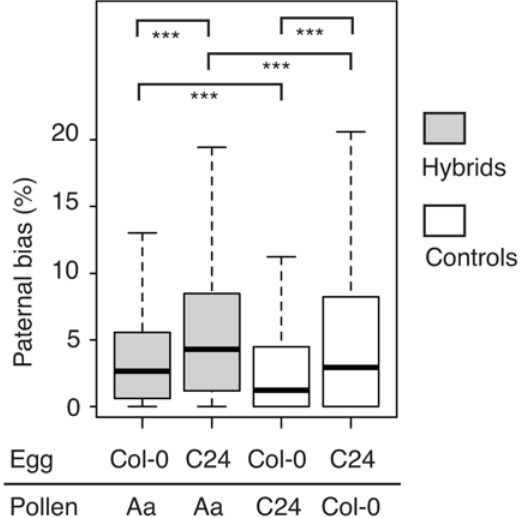
Fig 2. Overall changes in parental bias. Parental bias in transcripts of genes that were expressed in all crosses. Box plots illustrate how among commonly expressed genes interspecific crosses do not result in an overall erosion of paternal bias. Brackets indicate the outcome of Wilcoxon signed rank test ( *** : P <